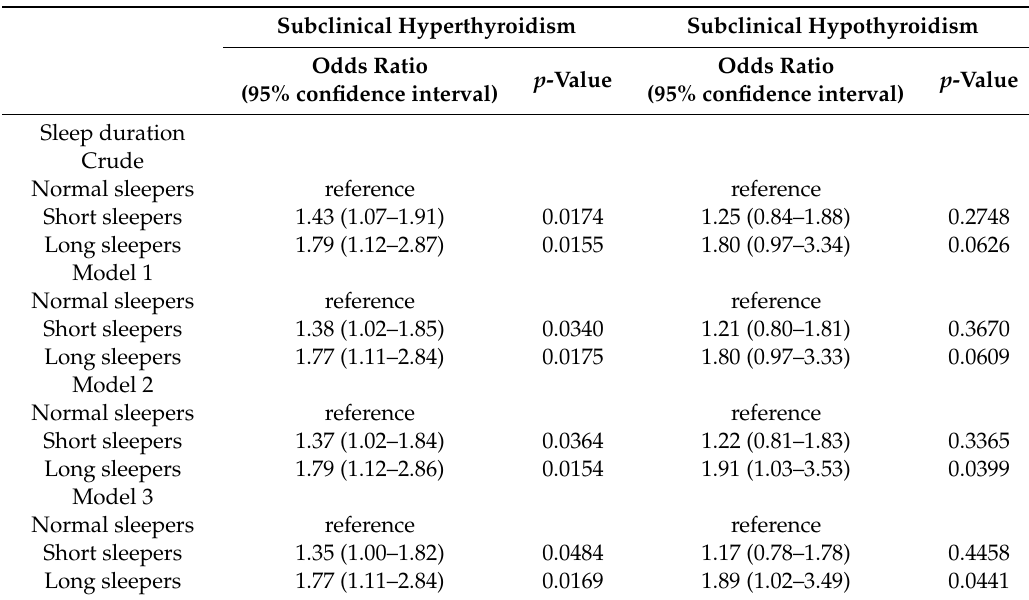
Table 3. Risk of subclinical thyroid dysfunctions according to sleep